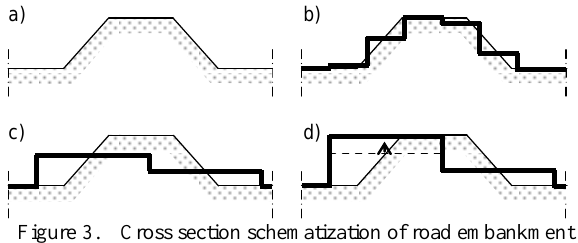
Figure 3. Cross section schematization of road embankment (a) and grid model representation: b) high resolution DTM, c) low resolution DTM and d) low resolution DTMs